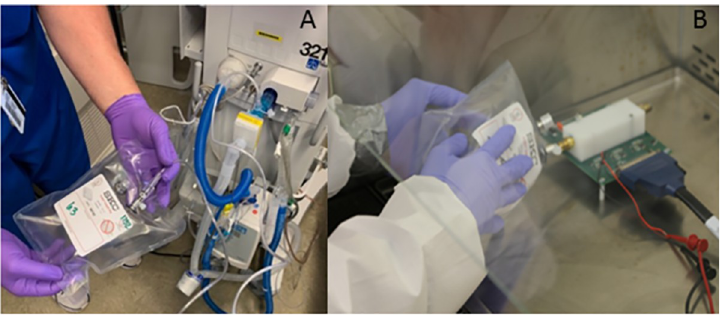
Fig 2. Breath bag collection technique. A. Breath bag was connected to exhalation port of ventilator at approximately 1 liter of exhaled gas was collected over 3–5 respiratory cycles. B. Samples were brought to a BSL 3 lab and attached to breathalyzer circuit in